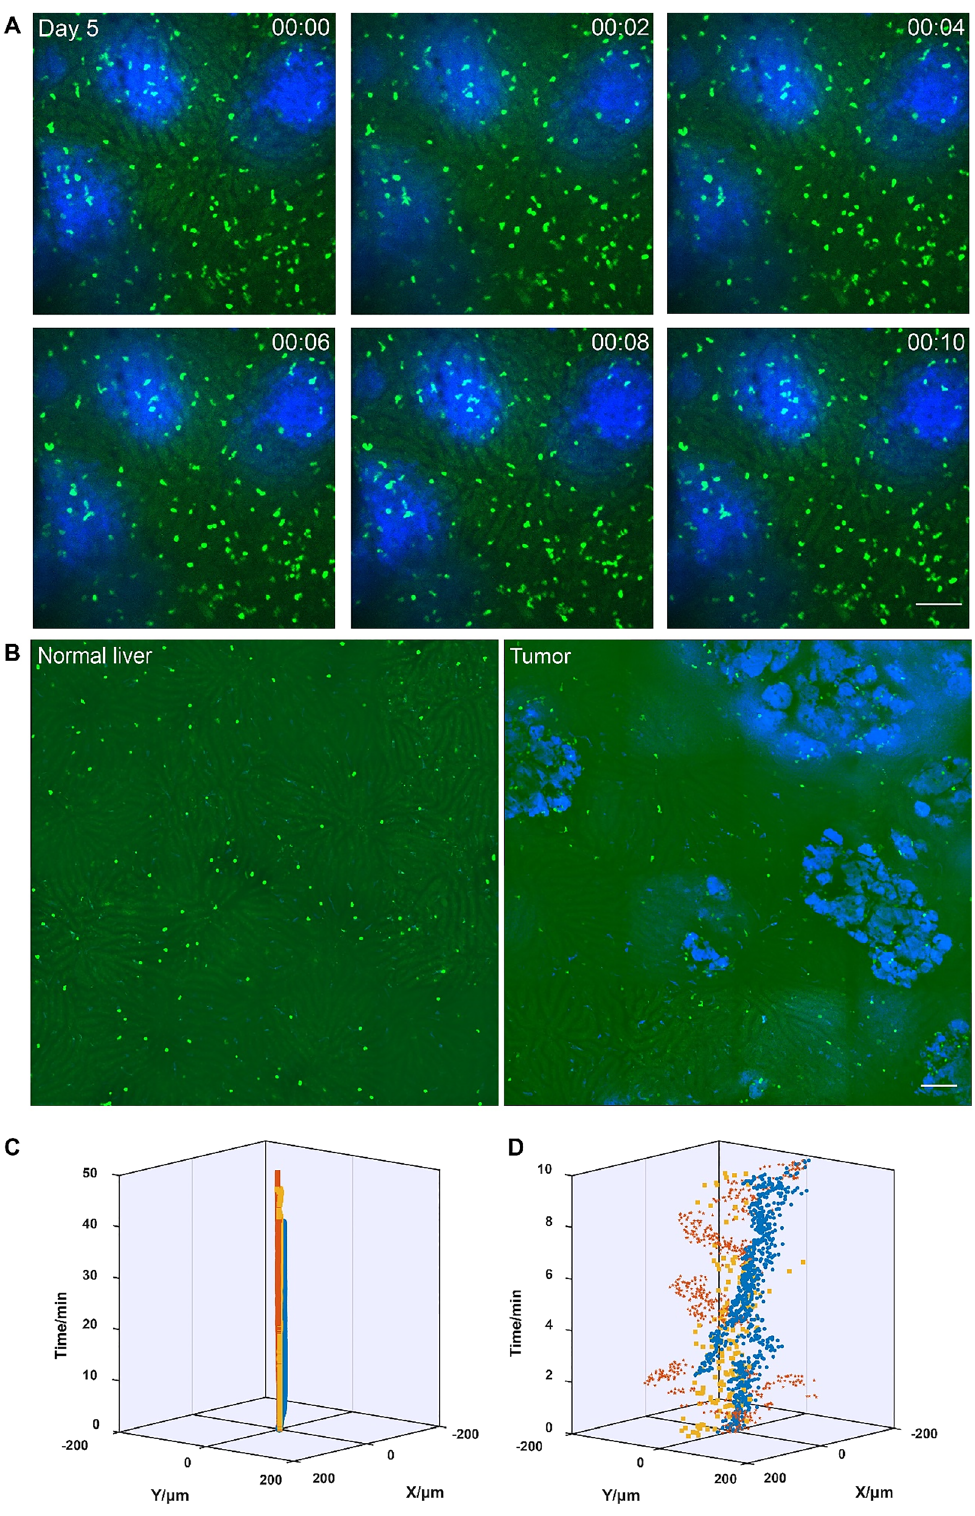
Figure 2: The DAW model enables confocal imaging to acquire high-quality, stable, and large-field images. (A) The spinning-disk confocal microscopy produced 10-s split-frame images from time-lapse videos of liver metastases in CXCR6-GFP mice using the DAW 5 days after tfRFP-B16 cell injection. Blue: tfRFP-B16 tumor metastases; Green: GFP-labeled iNKT cells. Field of view: 331.8 × 331.8 μ m; scale bar: 50 μ m. (B) The spinning-disk confocal microscopy acquired 4 × 4 large- fi eld images (1327.1 × 1327.1 μ m); scale bar:100 μ m.TheleftpaneldemonstratestheliverofnormalmicewiththeDAW,andtherightpanelshowstumorlivermetastasesofmicewith the DAW. (C – D) Displacement of confocal time-lapse imaging of the liver in mice with the DAW (C) and standard AIW (D). Scatter plots ( n = 3 time-lapse videos) showing the shift in imaging at each time point in the liver